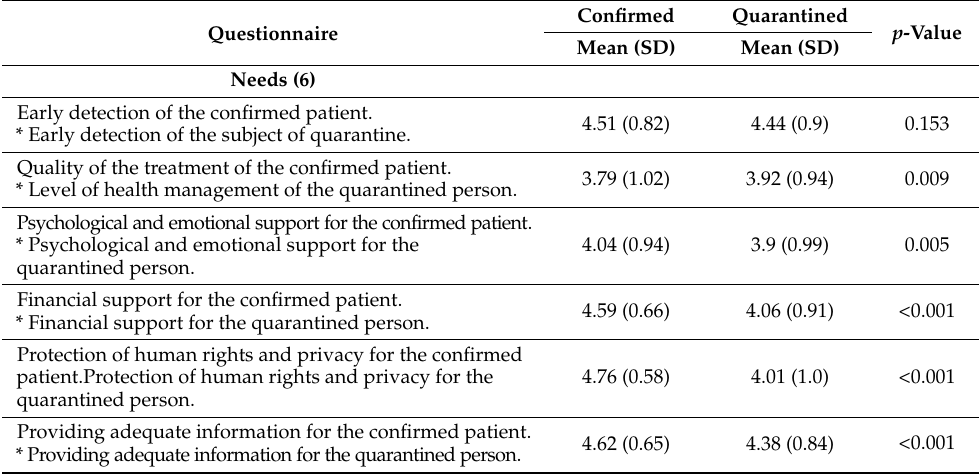
Table 6. Needs for confirmed patients and quarantined